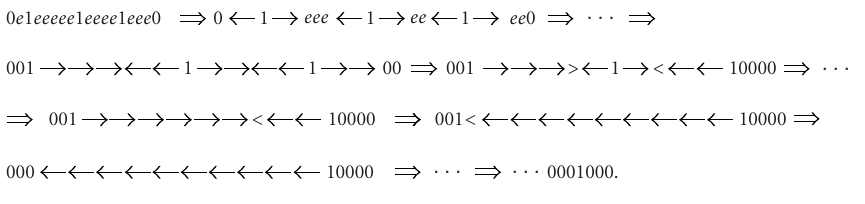
Figure 3.2. Toy particle evolution in 3-detector